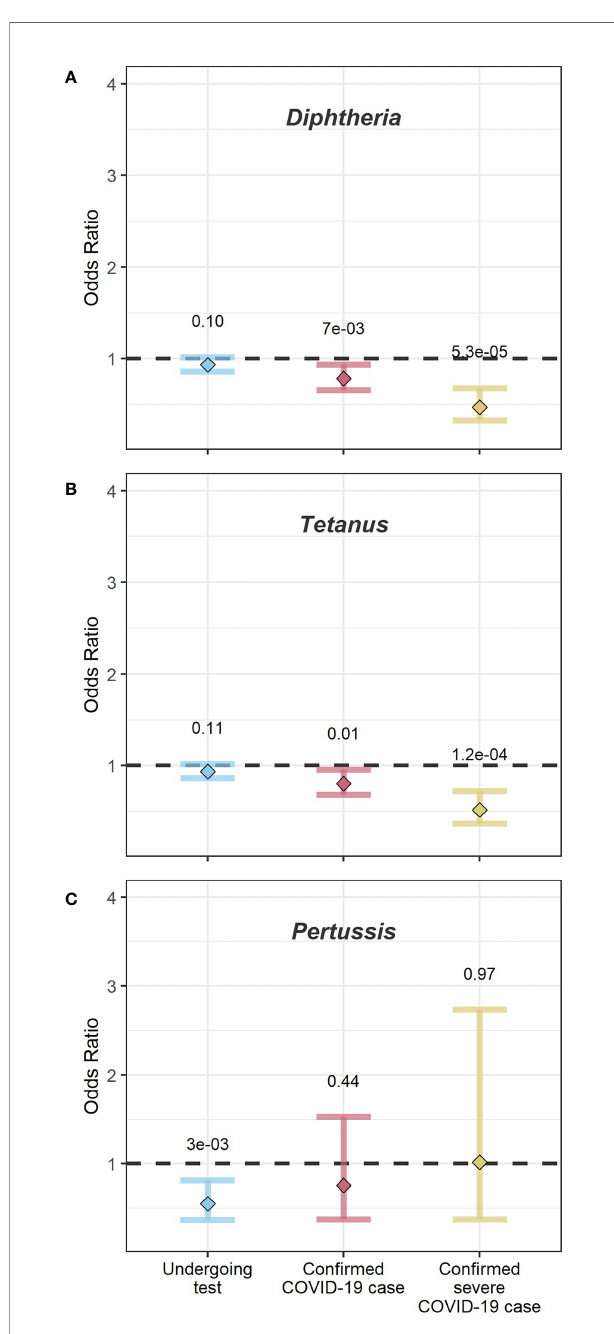
FIGURE 1 | Dot-and-whisker plots from logistic regression analysis across the full sample. The y-axis shows the odds ratios. The x-axis shows the three logistic regression analysis performed (1): undergoing a COVID-19 test (left, blue) (2), being a con fi rmed COVID-19 case (middle, red), and (3) being a con fi rmed severe COVID-19 case (yellow, right). Dots indicate the mean odds ratio, and whiskers the 95% con fi dence intervals. The numbers above the whiskers show the p-value for each analysis. Panel (A) shows the outcome for participants vaccinated for diphtheria, relative to those with no record of a diphtheria vaccination, (B) shows the outcome for participants vaccinated for tetanus relative to those with no record of tetanus vaccination; and (C) shows the outcome for participants vaccinated for pertussis relative to those with no record of vaccination for